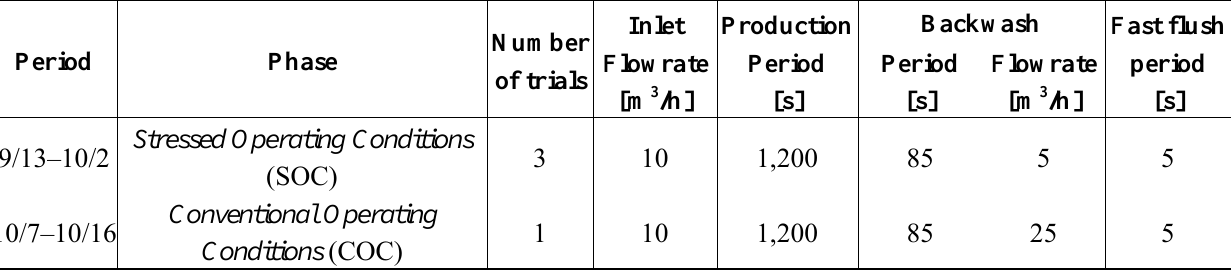
Table 1. Experimental plan and typical process cycle characteristics for the two experimental